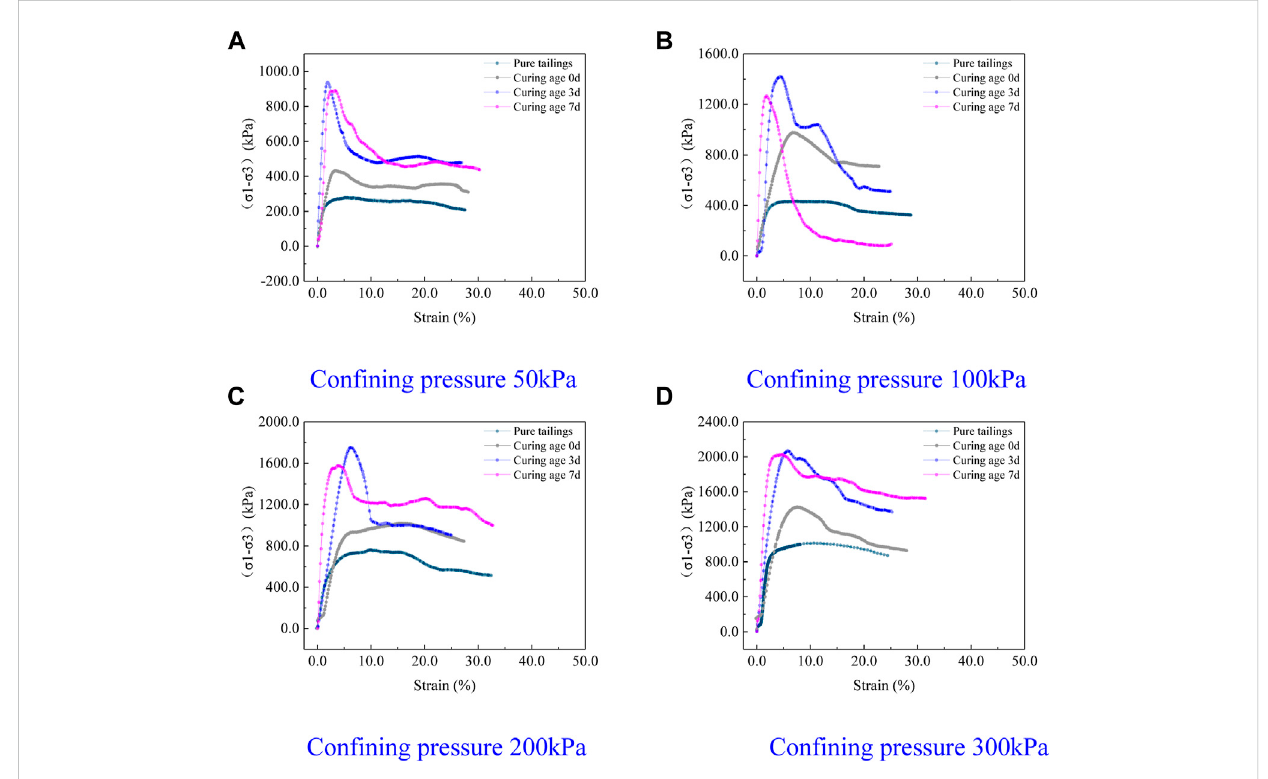
FIGURE 7 Stress-axial strain of different con fi ning pressure under same curing age.